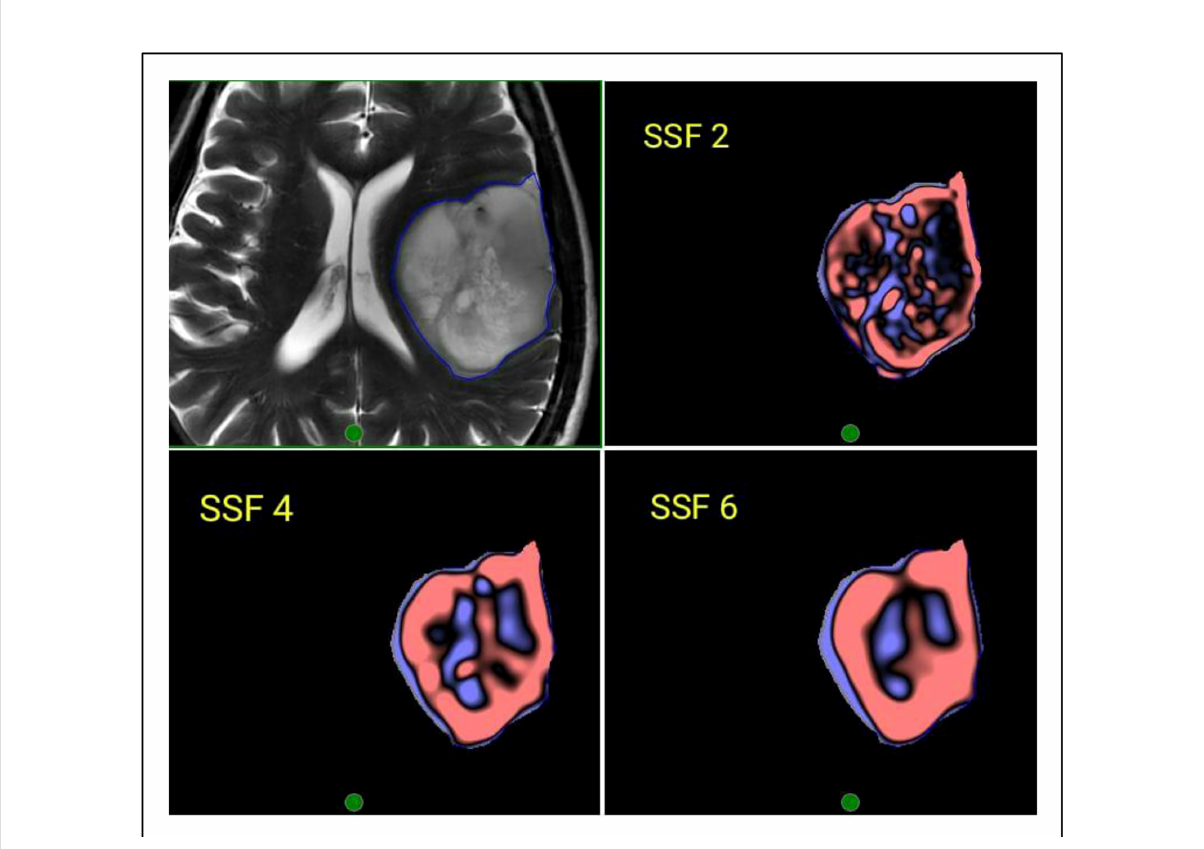
FIGURE 3 Representative image of the region of interest (ROI) contoured on a T2W MRI and corresponding fi ltered images using Laplacian of Gaussian (LOG) bandpass fi ltration algorithm showing SSF-2 ( fi ne texture), SSF 4 (Medium texture), and SSF 6 (Coarse